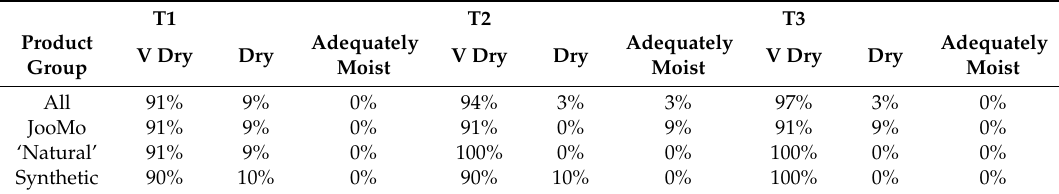
Table A2. Comparison of the percentage in each skin moisture group of the study subjects based on the Corneometer measurements before product use (=T1), after 2 weeks of product use (=T2) and after 4 weeks of product use (=T3).